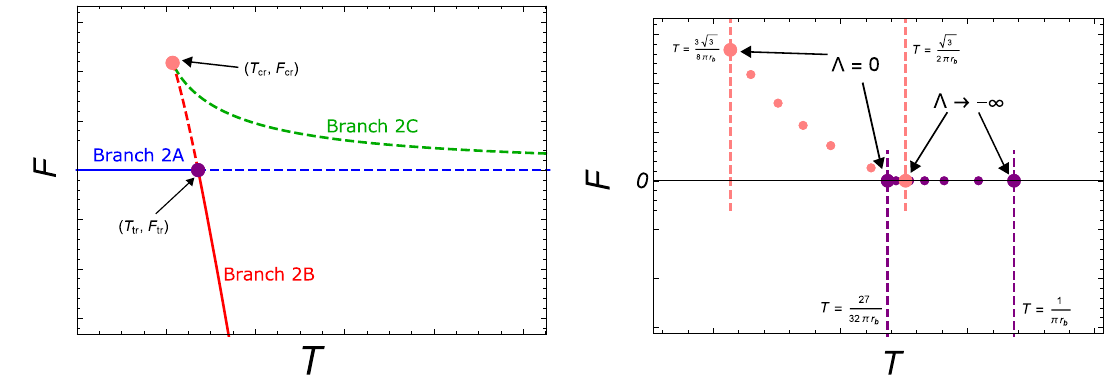
Figure 3 . ( Left ) Qualitative behavior of free energies of saddles 2A, 2B, and 2C. The portion that does not give a dominant contribution is dashed. The critical point and the transition point are marked. The temperature and free energy at those points are T = 1 /β ( r Λ) and b , cr ( tr ) cr ( tr ) = I os, + ( β ( r Λ) = I os, − ( β ( r Λ) . ( Right ) Behaviors F , r b , Λ) /β , r b , Λ) /β b , b , cr ( tr ) cr ( tr ) cr ( tr ) cr ( tr ) cr ( tr ) of critical point and transition point against Λ on T - F plane.